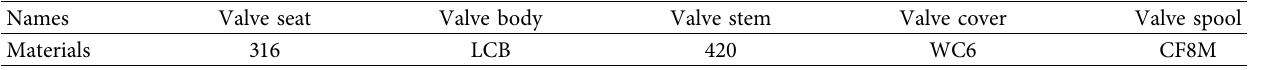
Table 1: Each main component